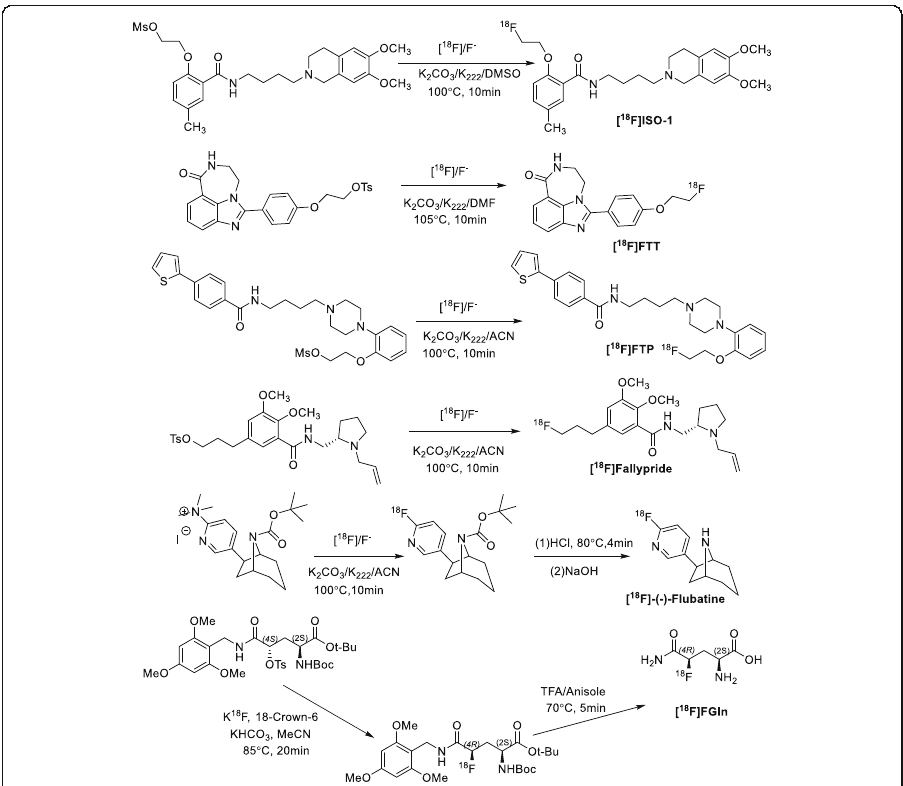
Fig. 5 Scheme for the radiosyntheses of the six radiotracers